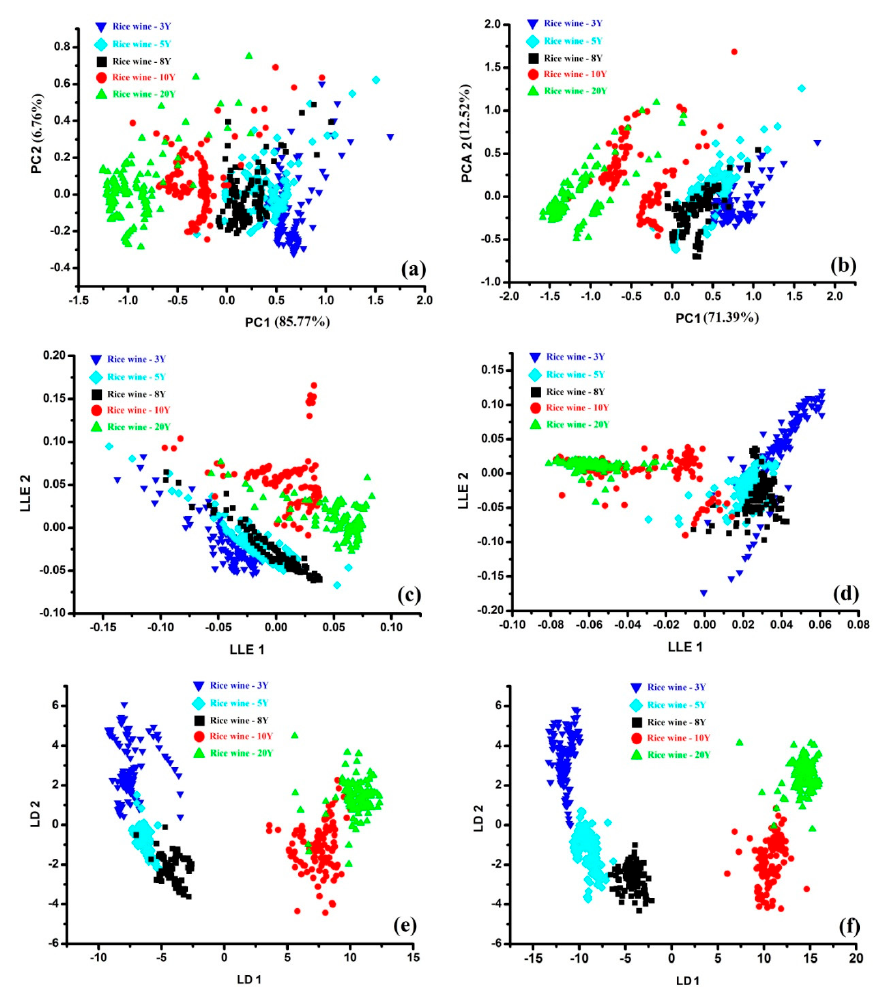
Figure 5. The classification results of PCA based on TIOP ( a ), TIOP-AIOP ( b ). The classification results of LLE based on TIOP ( c ), TIOP-AIOP ( d ). The classification results of LDA based on TIOP ( e ), TIOP-AIOP ( f ).